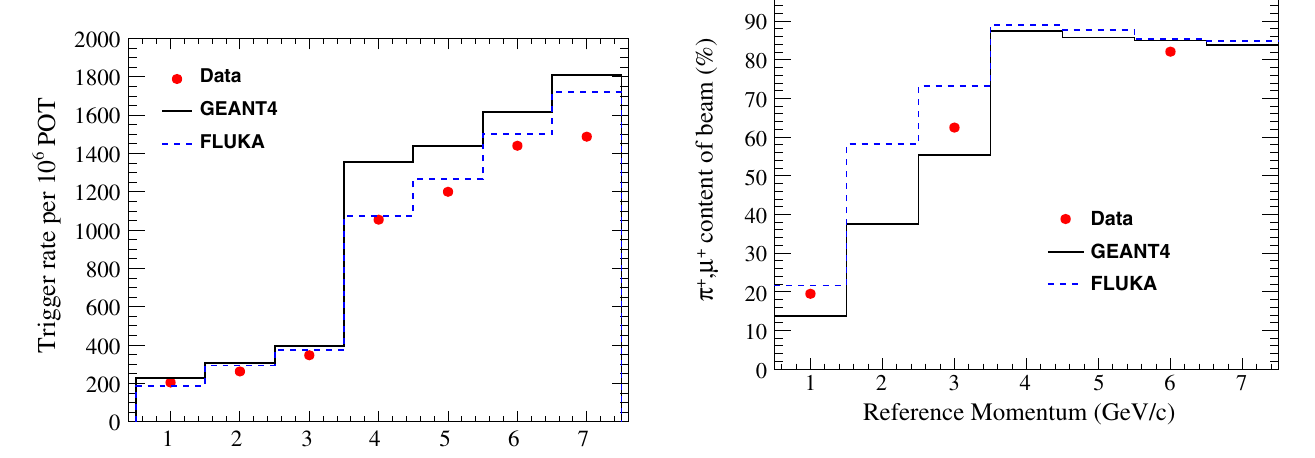
FIG. 21. Measured and simulated relative beam content for pions and muons for 1 and 3 GeV =c . The 6 GeV =c data point was obtained using the copper target, and also includes the positrons that cannot be distinguished from pions and muons for momenta ≥ 4 GeV =c . Data and simulations are in satisfactory agreement.